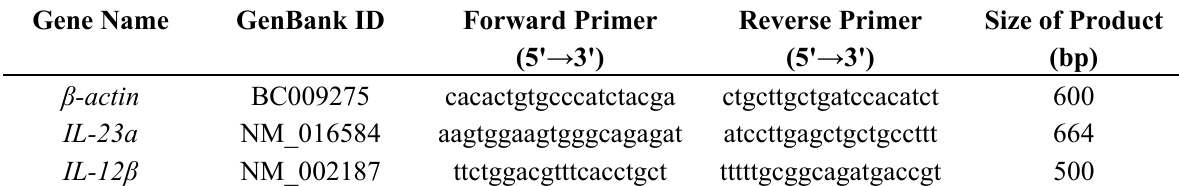
Table 1. Primers used in RT-PCR